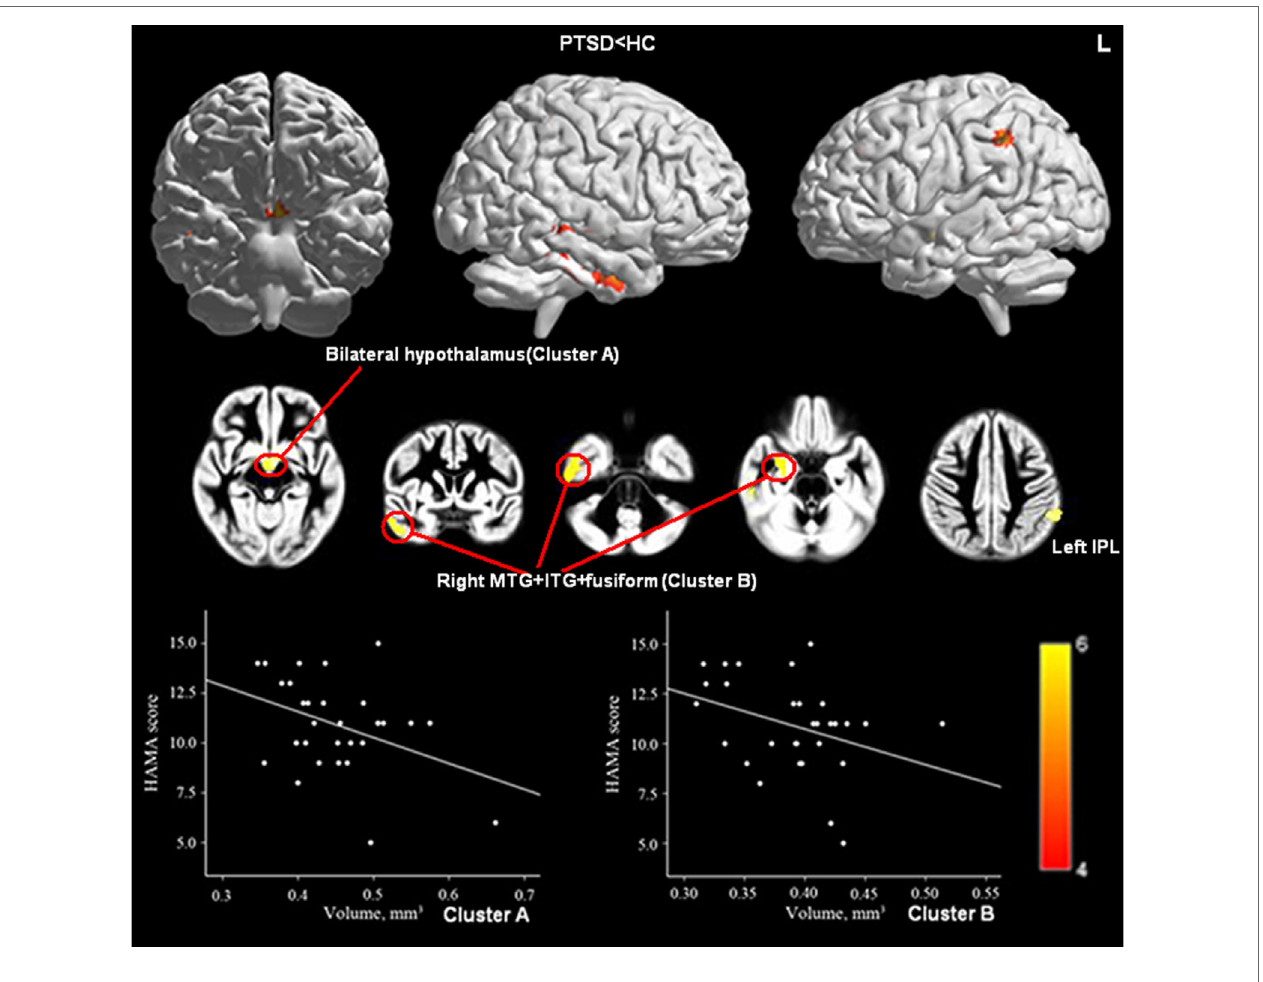
FigUre 2 | significant gMV decrease in patients with PTsD compared with controls (upper panel) and correlations between haM-a scores and gMV of cluster a (bilateral hypothalamus; Peak, x = − 5, y = − 4, z = − 9, Mni) and cluster B (right MTg,